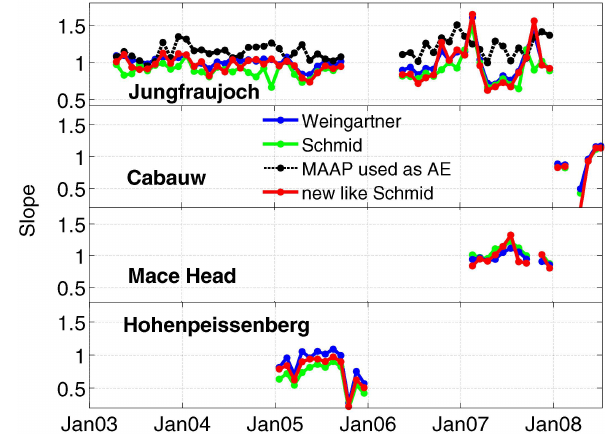
Fig. 7. Histogram of the relative change (in percent) of AE de- rived ˚ a abs values using Arnott, Schmid and the new corrections, the method similar to Schmid being represented here. The JFJ and CAB datasets are presented in light and dark colors, respectively. The numbers of cases represented for ± 100% correspond to ˚ a abs changes equal or greater than ± 100%, with values reaching some- times up to ± 200% or greater.